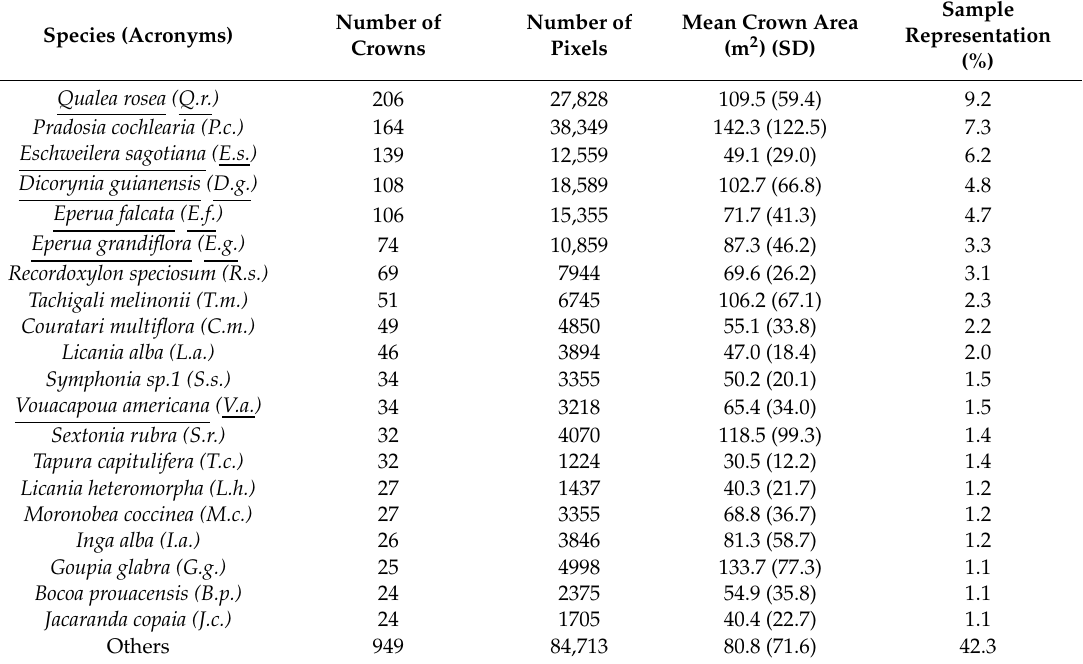
Table 1. List of target species, and corresponding number of crowns and total number of pixels retained for analysis (each crown was imaged twice, but some pixels were removed due to low illumination or NDVI values). Sample representation refers to the proportion of manually segmented crowns of a given species. Mean crown area followed by standard deviation in brackets. Commercial species are